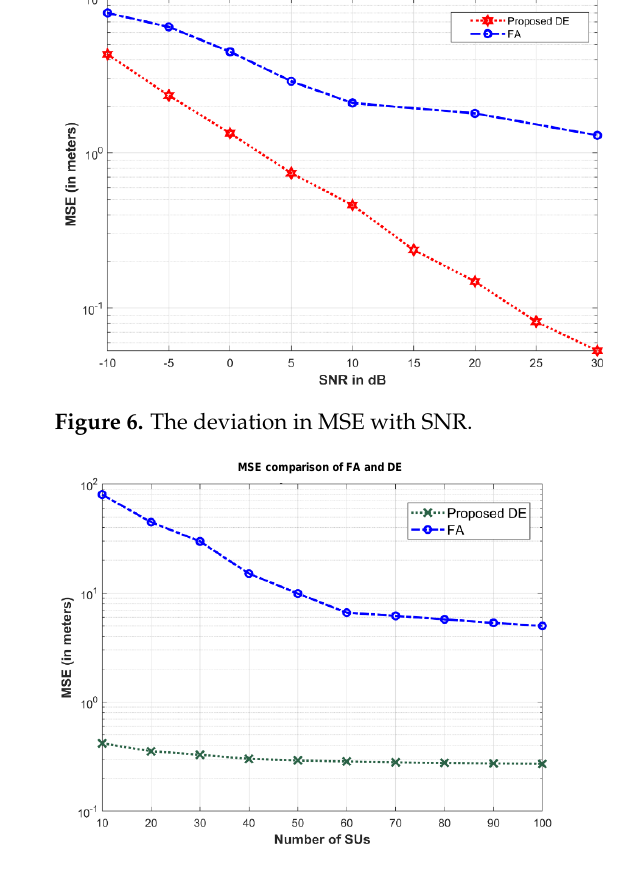
Figure 6. The deviation in MSE with SNR.